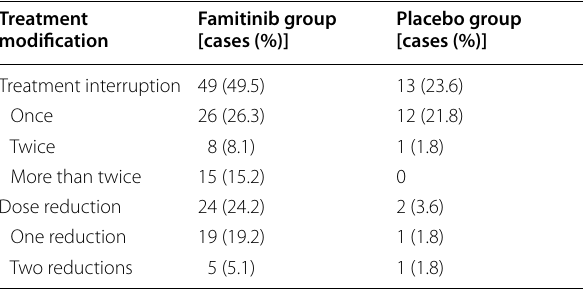
Table 2 Treatment modification based on patients’ toler-